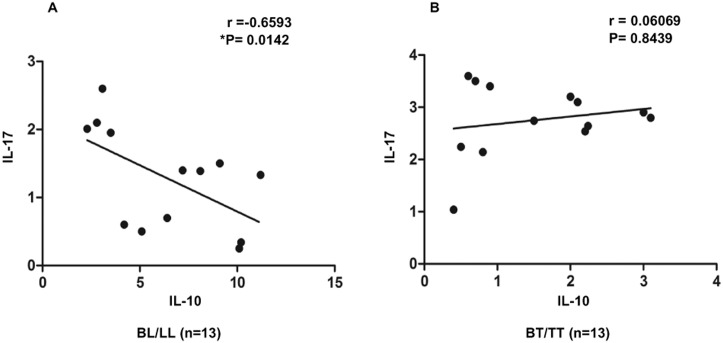
Inverse Correlation between IL-10 and IL-17 in BL/LL.A) Treg derived high IL-10 negatively correlates with low IL-17+ CD4 T cells in BL/LL (n = 13) signifying polarized immunity in leprosy. B) No correlation was found in BT/TT (n = 13). Correlation was done using Spearman rank correlation coefficient; r value was equal to -0.65 while p value was significant at 0.01 in case of BL/LL.